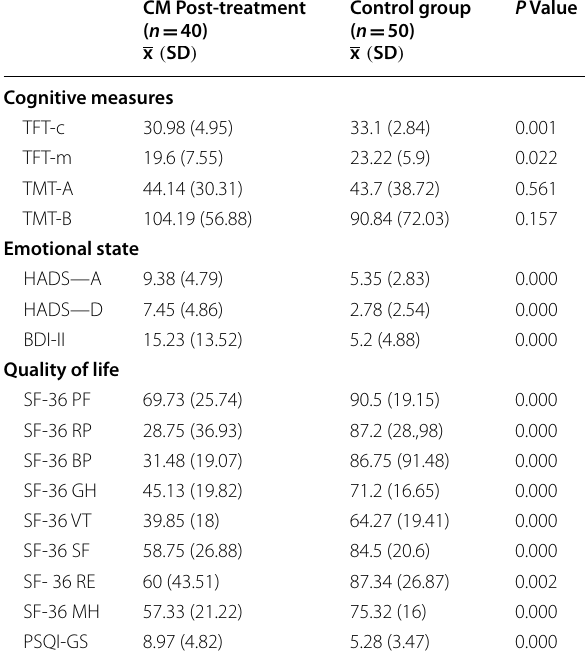
Fig. 3 Results of the ROCF memory task in the CM group at baseline and 3 months after preventive treatment. ROCF‑m: Rey‑Osterrieth Complex Figure test, memory task Table 4 Comparison between the CM group after three months of preventive treatment ( n 40) and the control group ( n 50) = = in the cognition and quality of life scales